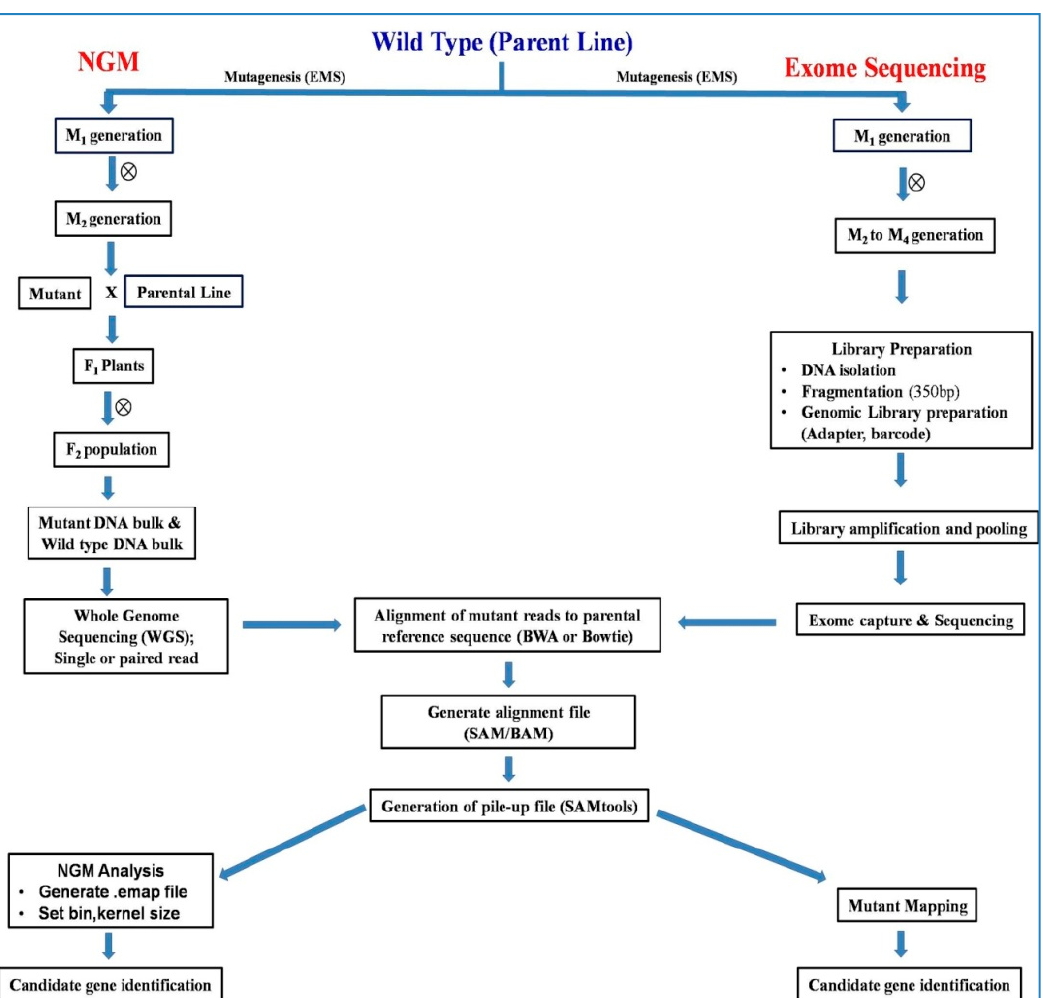
Figure 2. Flow diagram showing the major steps of next generation mapping (NGM) and exome sequencing approaches of forward genetic screen.